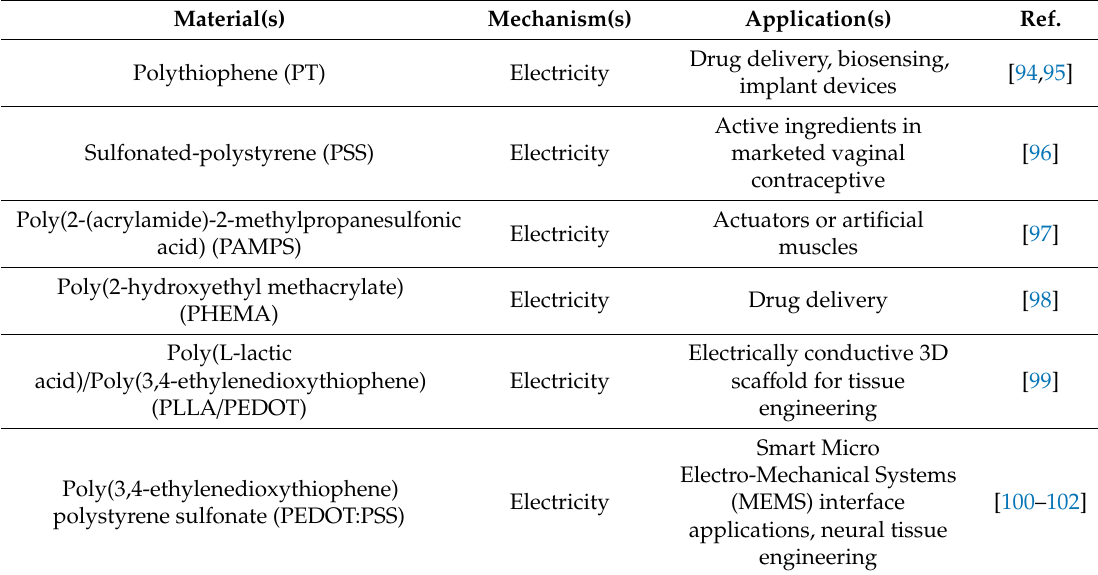
Table 3. Overview of the experiments on 4D (bio-)printing and other manufacturing approaches using electricity as a predefined